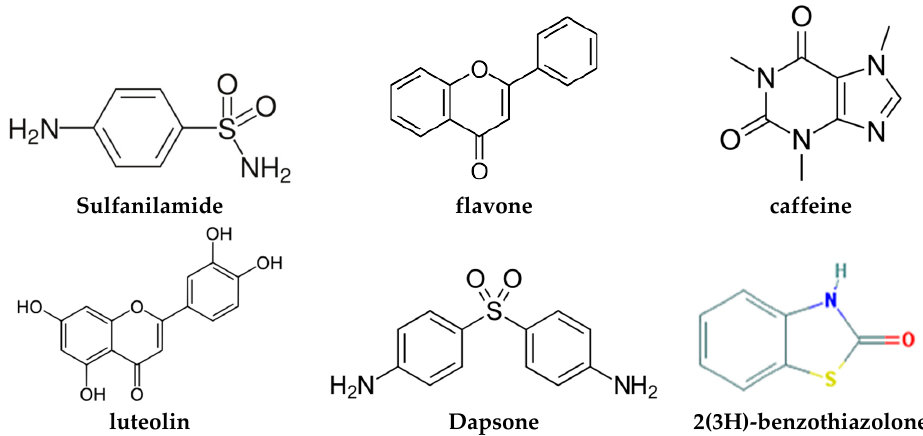
Scheme 2. Molecular structure of Dapsone and coformers studied.